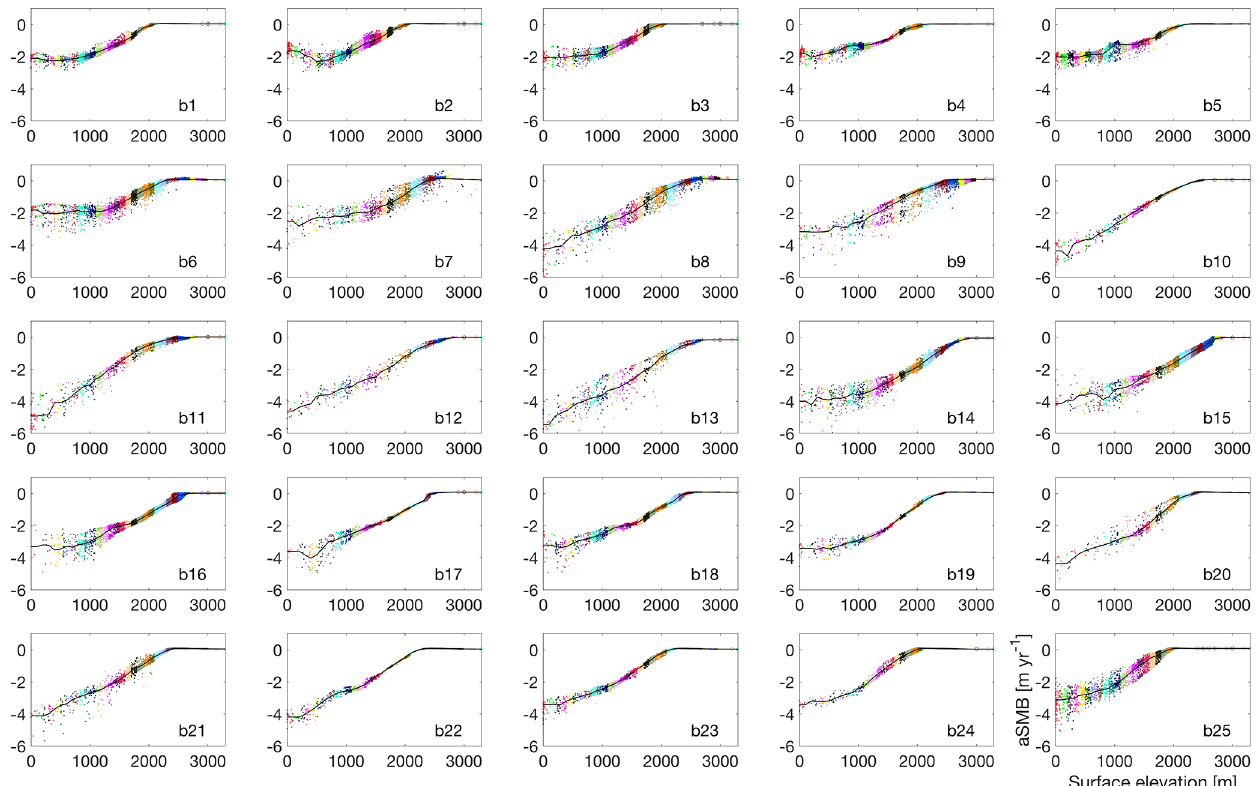
Figure 3. SMB anomaly (metres of ice equivalent per year) from the RCM MAR (scatter) and with the elevation interval medians (used for the mapping) shown with a black line. Different colours indicate the elevation ranges considered for the elevation–aSMB lookup table. The sub-figure labels indicate the basin identifiers as defined in Fig.